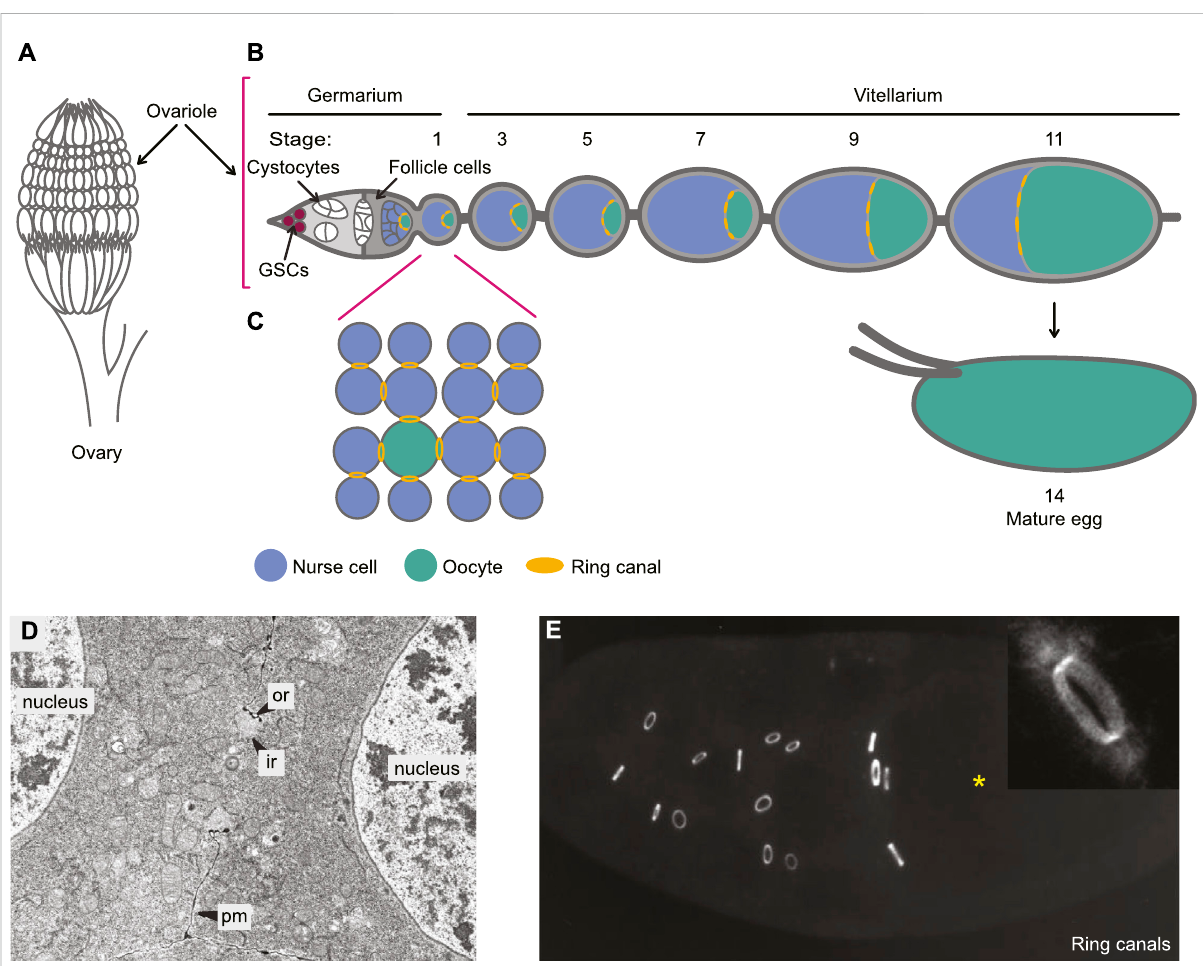
FIGURE 3 Ring canals during oogenesis in the Drosophila ovary. (A) Each ovary in female Drosophila contains 16 – 23 ovarioles. (B) Oogenesis is polarized alongthelengthofeachovariole,with germline stemcells(GSCs)andmitotic cystocytes intheanterior germarium, maturingeggchambersarrayed alongthevitellarium,and matureeggs (stage 14)attheposterior. (C) Cystocytedivisions areincomplete,givingriseto a16-cellcyst that ismaximally branched, with cystocytes connected by stable intercellular bridges called ring canals. The oocyte develops from one of the two cystocytes with the most ring canals. The remaining cells differentiate as nurse cells. (D) An electron micrograph showing a ring canal between two nurse cells. The ring canal forms a break in the plasma membrane (pm) and is composed of an inner (ir) and outer (or) rim. (E) A stage 10 egg chamber with ring canals immunostained for hu-li tai shao (Hts). The oocyte is indicated with an asterisk. Insert shows the actin staining pattern for a ring canal from an egg chamber of the same stage. (D) and (E) adapted with permission from Robinson et al., 1994, The Company of Biologists,